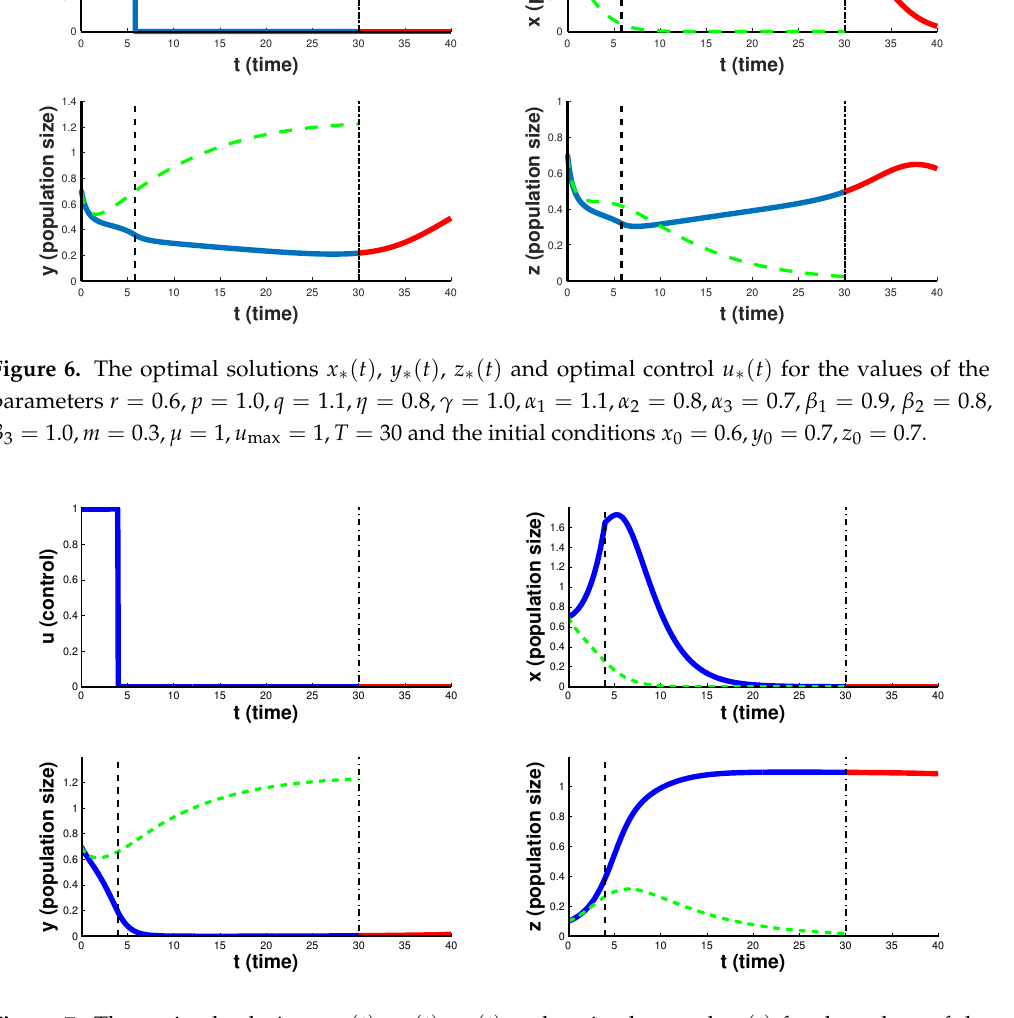
Figure 7. The optimal solutions x ∗ ( t ) , y ∗ ( t ) , z ∗ ( t ) and optimal control u ∗ ( t ) for the values of the parameters r = 0.6, p = 1.0, q = 1.1, η = 0.8, γ = 1.0, α 1 = 1.1, α 2 = 0.8, α 3 = 0.1, β 1 = 0.9, β 2 = 0.8, β 3 = 1.0, m = 0.3, µ = 1, u max = 1, T = 30 and the initial conditions x 0 = 0.7, y 0 = 0.7, z 0 =